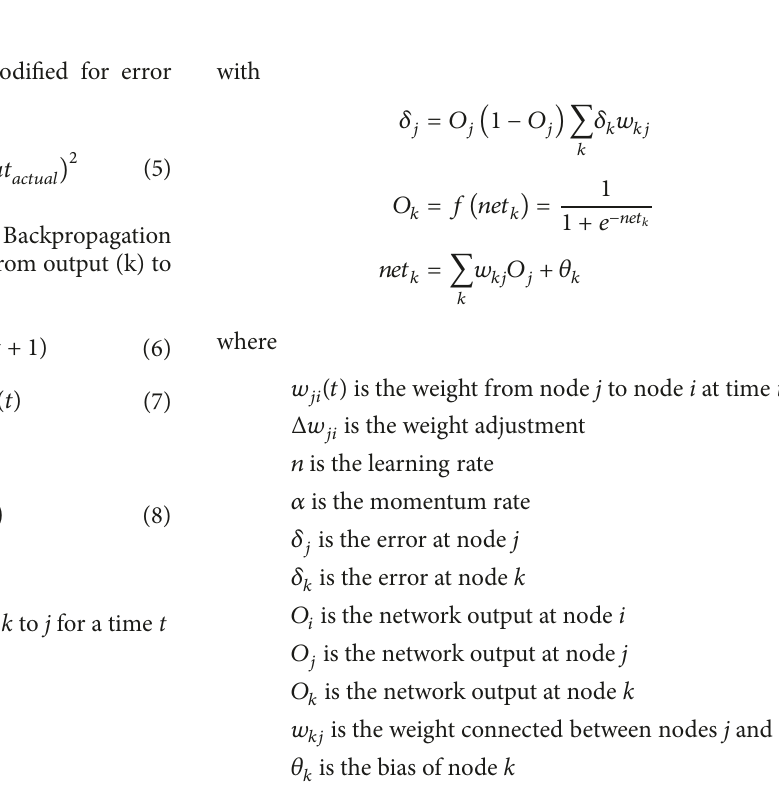
Figure 2: Combination of ANN with Multilayer Perceptron (MLP) model